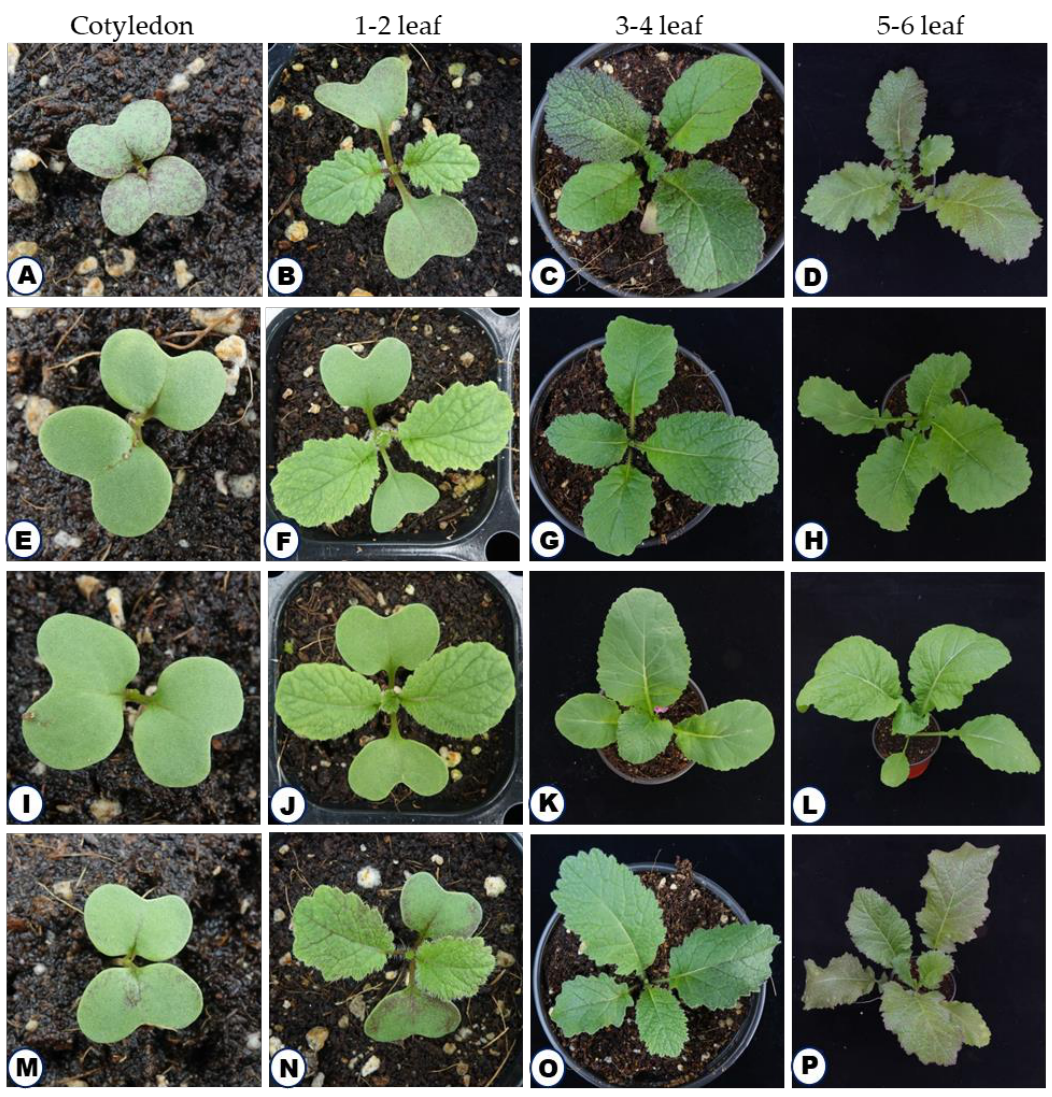
Figure 4. Representative figures of four different growth stages of four Brassica juncea varieties used in the study. ( A – D ), Jukgot; ( E – H ), Chungot; ( I – L ), Dolsangot; ( M – P ), Earlchungot. Growth